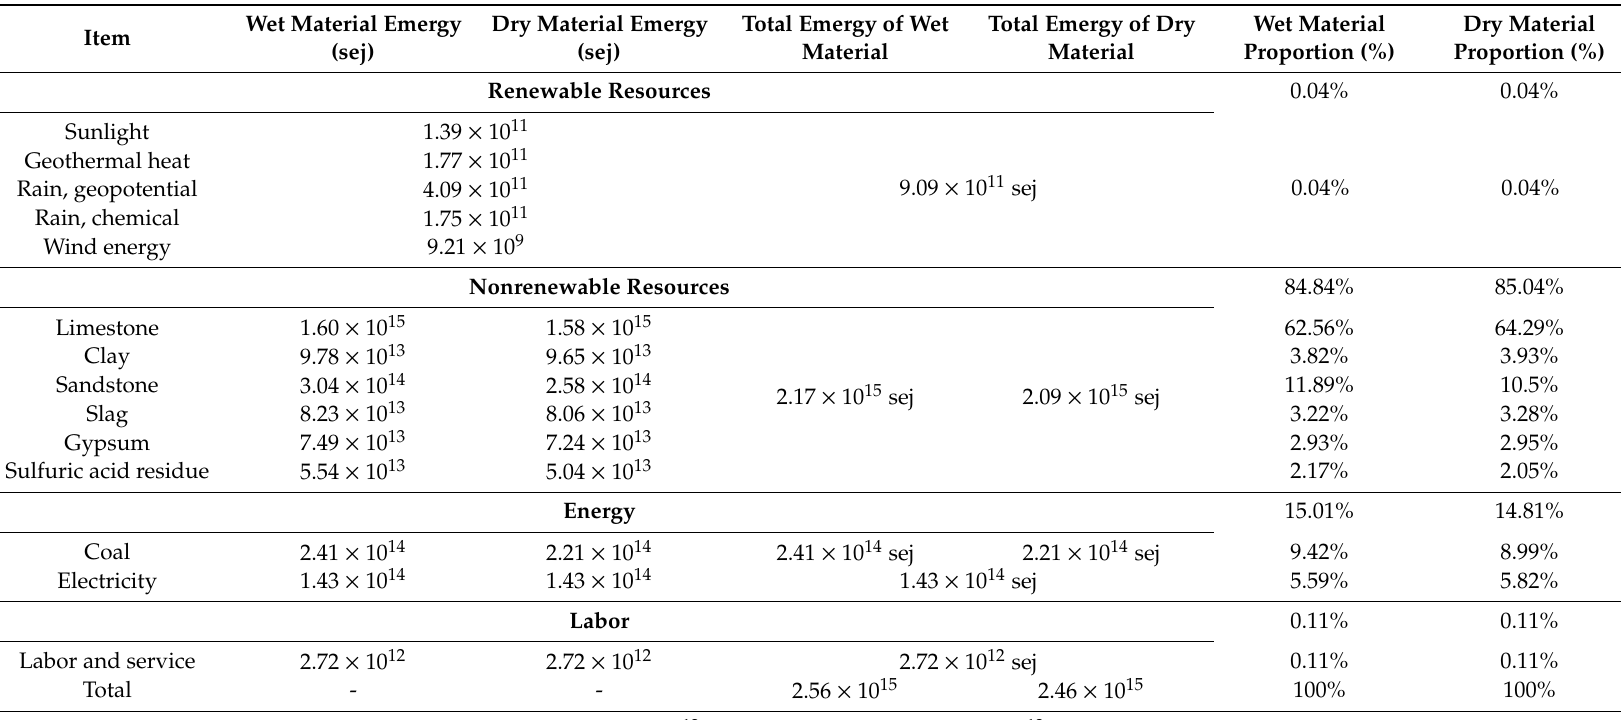
Table 19. Emergy analysis table of cement manufacturing in